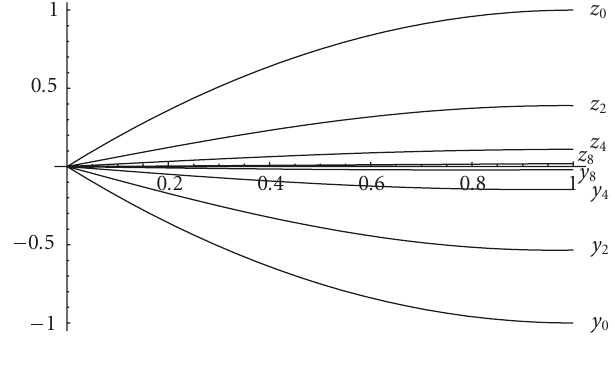
Figure 3.1. Some iterations for Example